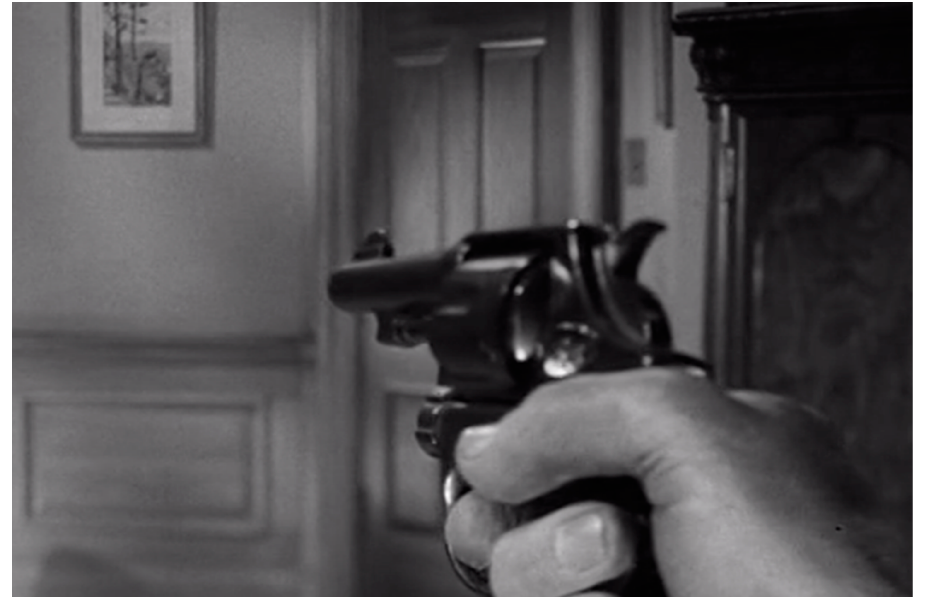
Figure 6. Image from Spellbound (1945) [6].